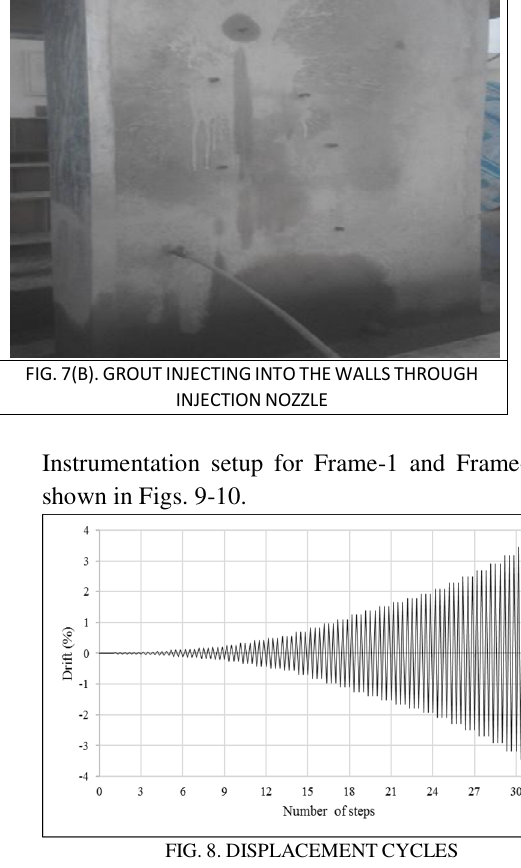
FIG. 8. DISPLACEMENT